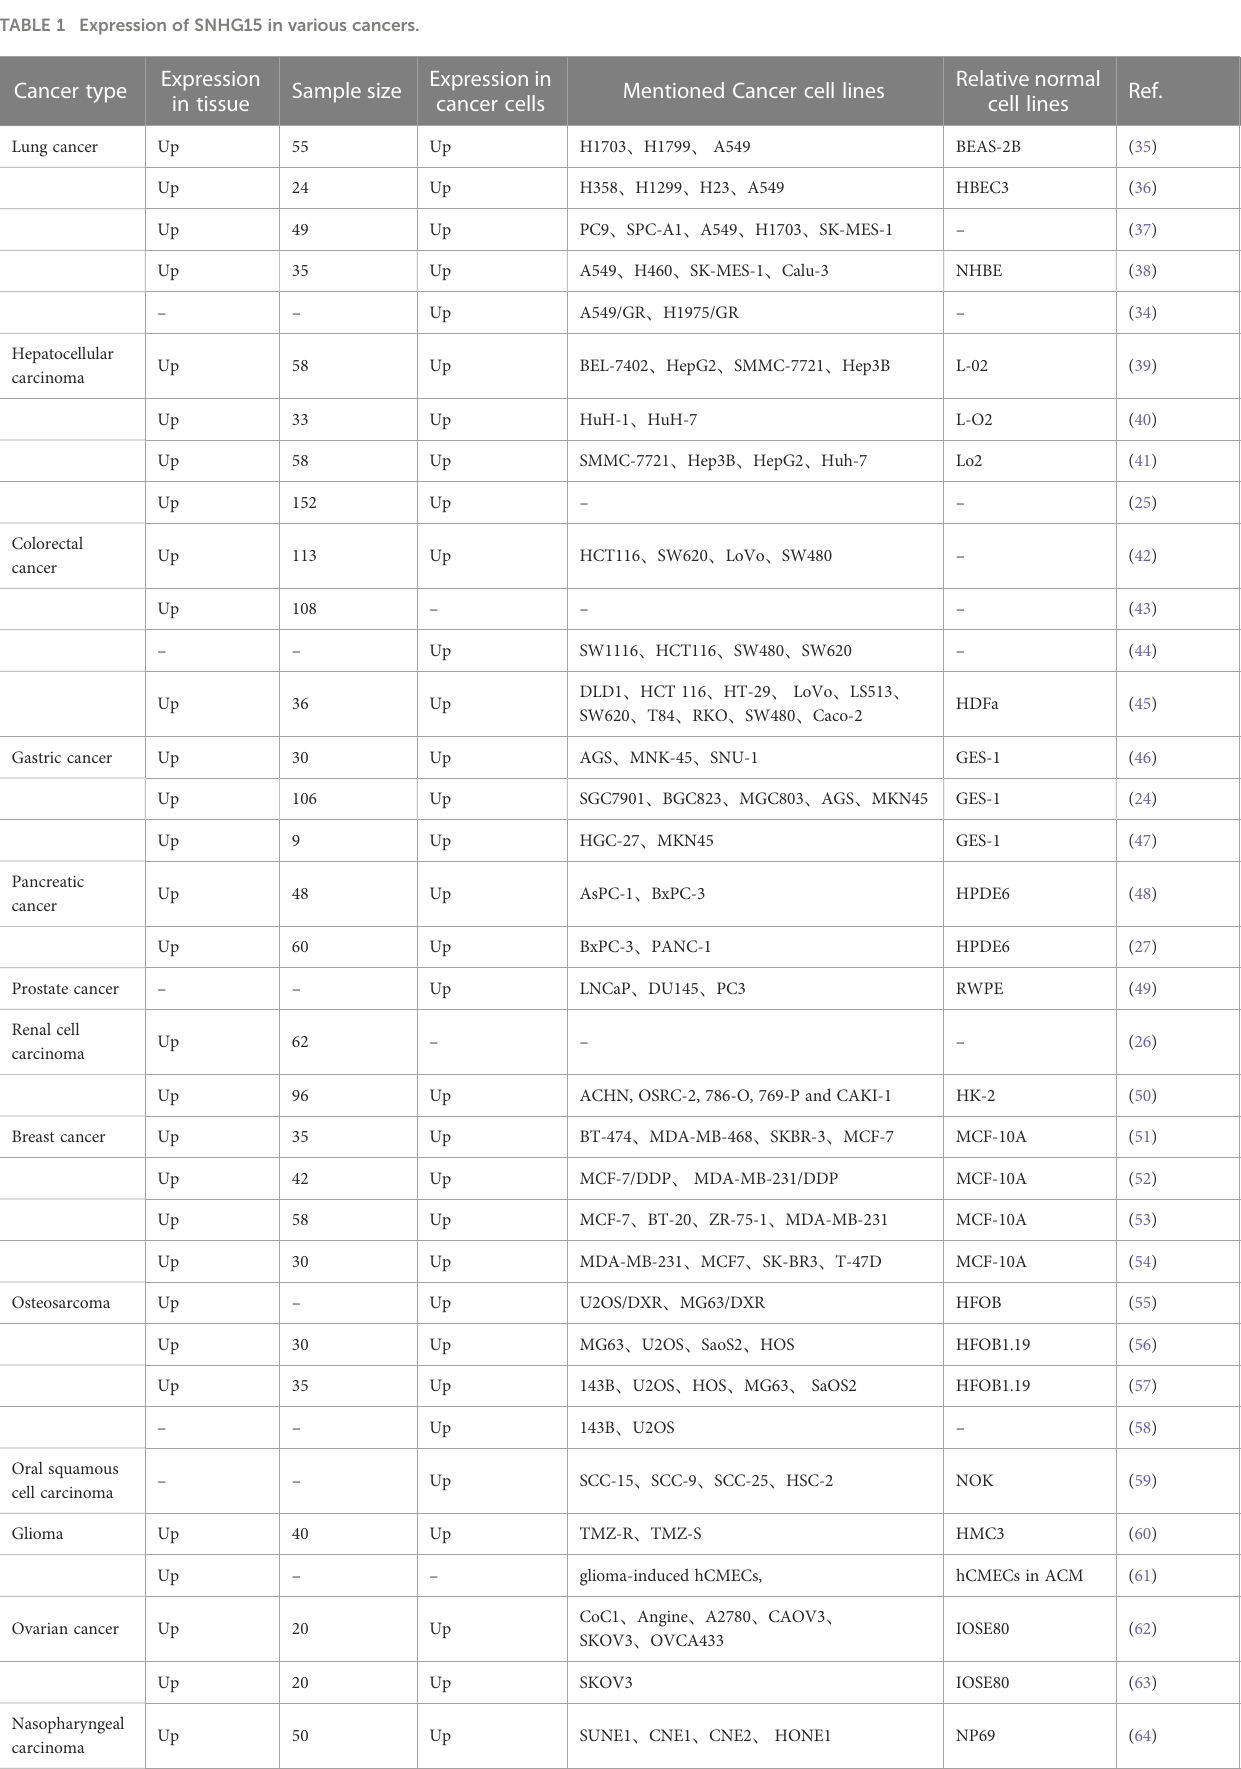
TABLE 1 Expression of SNHG15 in various